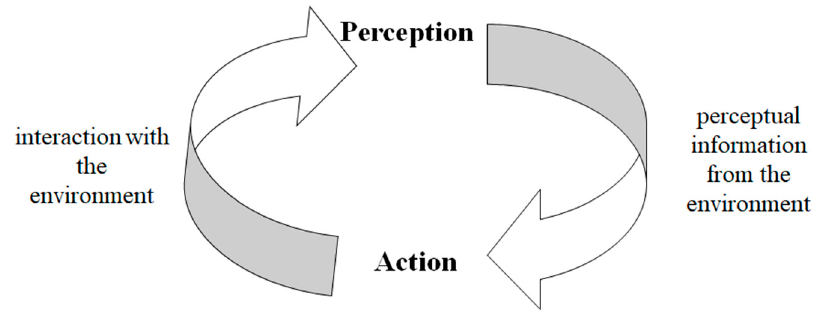
Figure 1. A schematic illustrating Perception–Action Coupling.